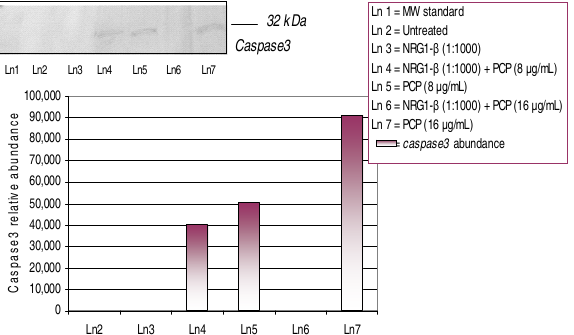
Figure 8: Expression and relative abundance of caspase-3 in AML 12 mouse hepatocytes exposed to PCP and NRG1- β + PCP for 48h. Caspase-3 protein